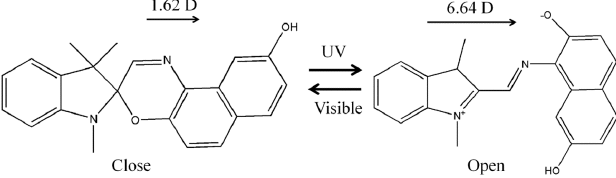
Figure 1. Photochromic molecular transformation of SO derivative dye and its dipole moment change under UV irradiation.